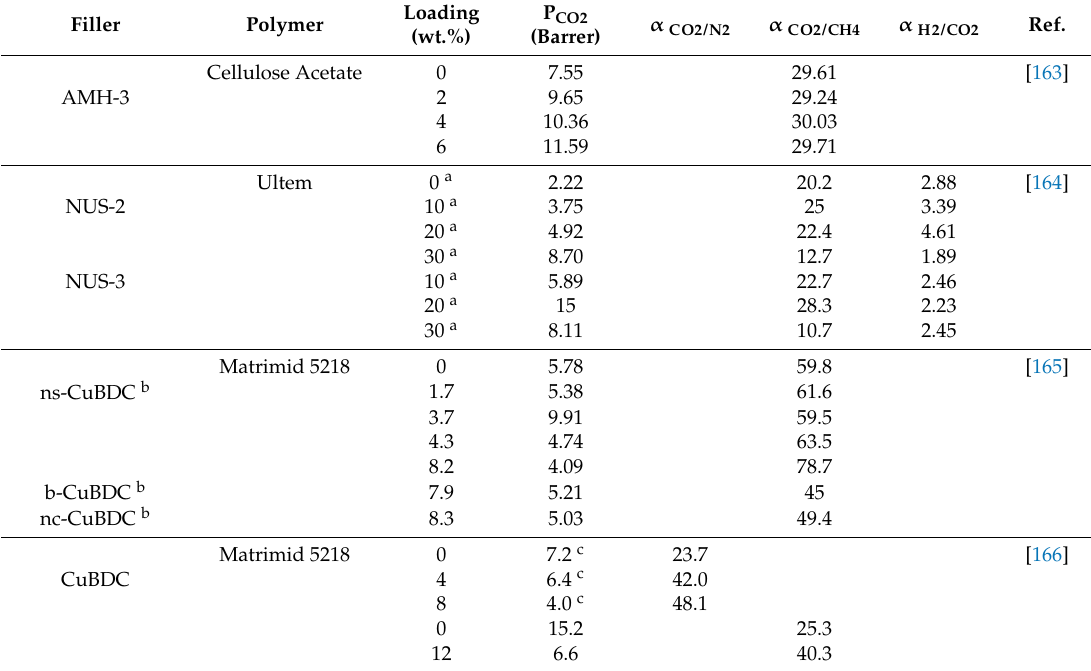
Gas separation performance of mixed matrix membranes containing MOFs nanosheets (operating conditions ranging within 1–5 bar, 20–35 ◦ C, mixed gas conditions unless differently